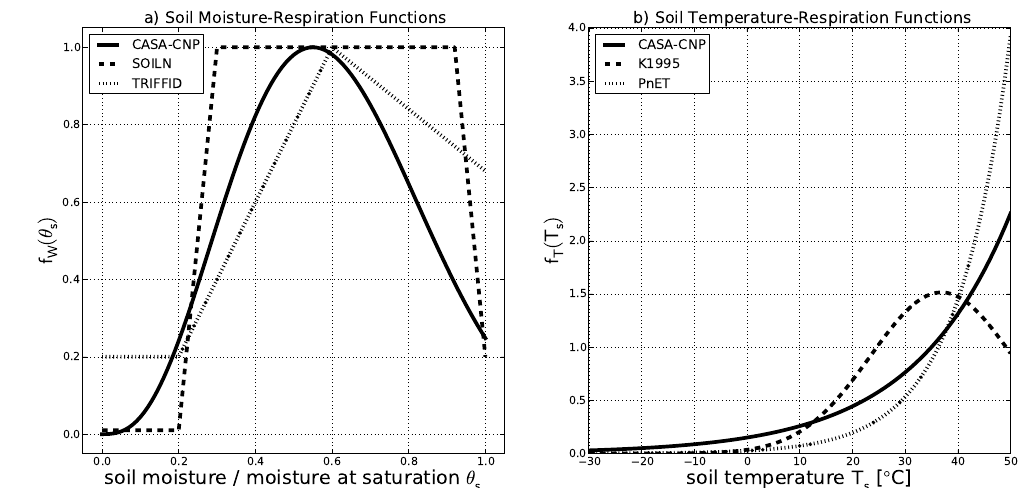
Fig. 1. Various f T and f W implemented in the CASA-CNP model